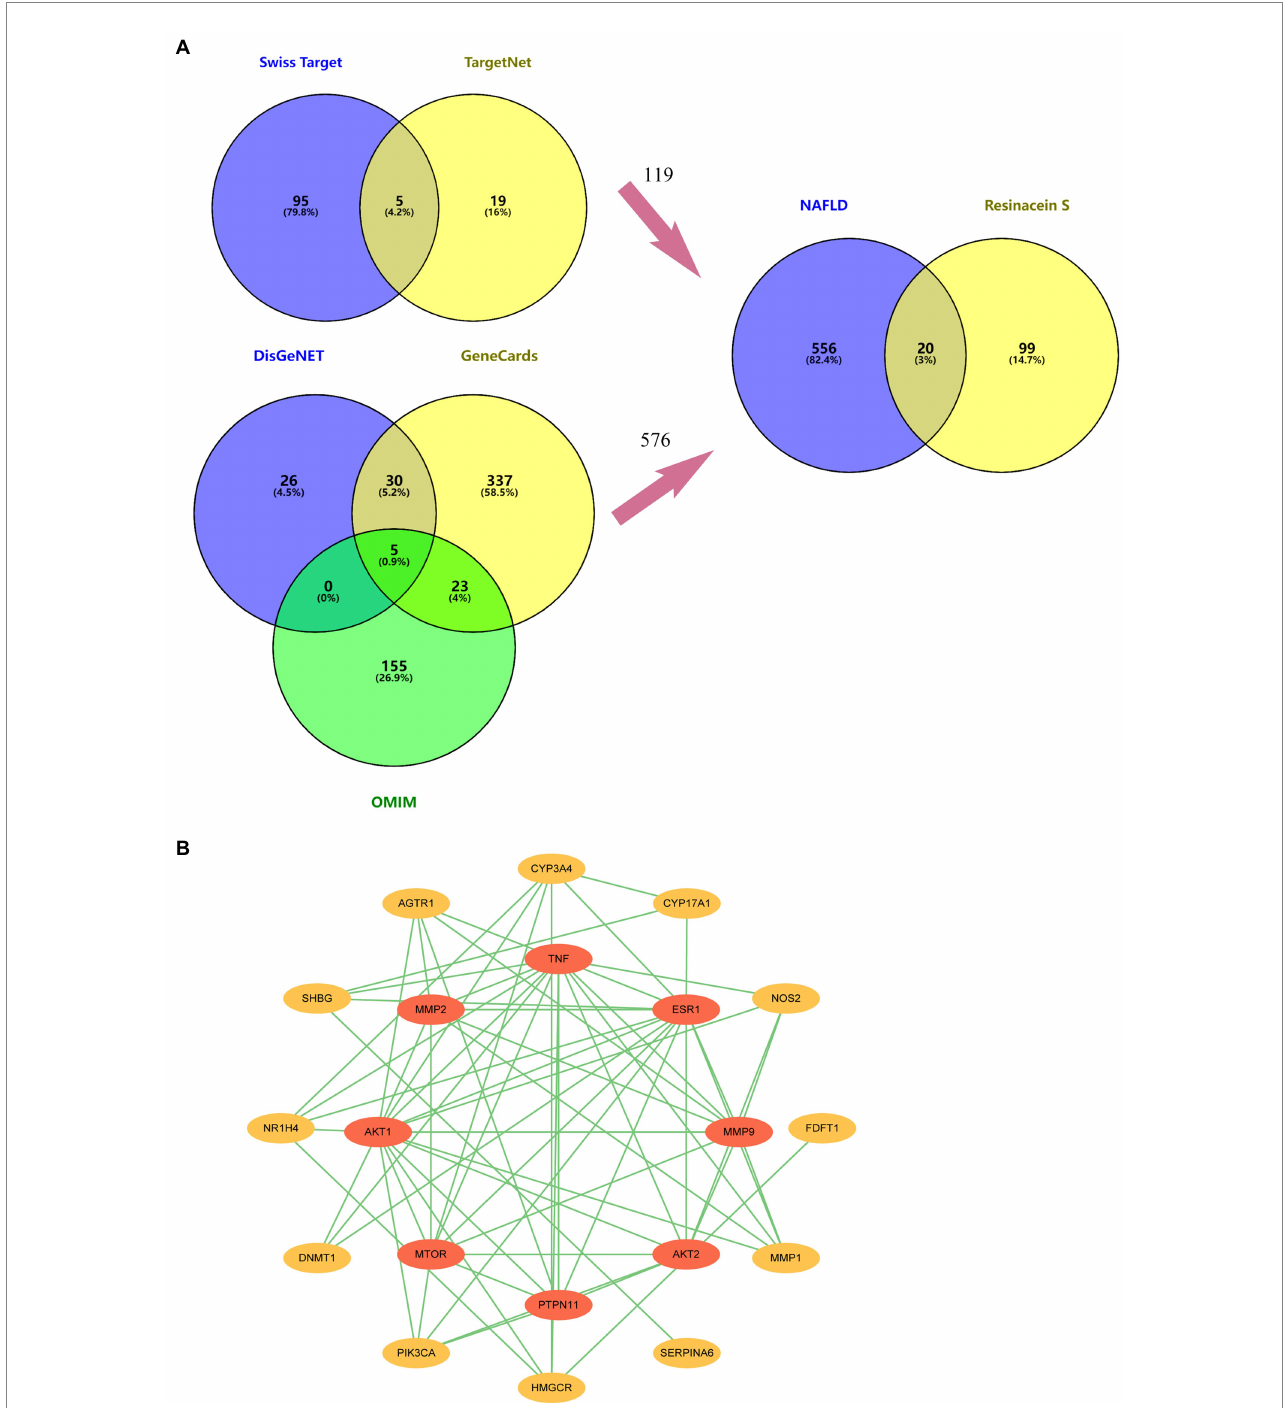
FIGURE 3 (A) 119 drug treatment targets based on the examination and combination of Swiss Target Prediction and TargetNet databases. Five hundred and seventy six genes related to NAFLD based on the examination and combination of DisGeNET, GeneCards and OMIM databases. There are 20 intersection targets between NAFLD and Resinacein S. (B) PPI protein interaction network diagram, in which the innermost circle degree value is 0–6, and the outer circle degree value is